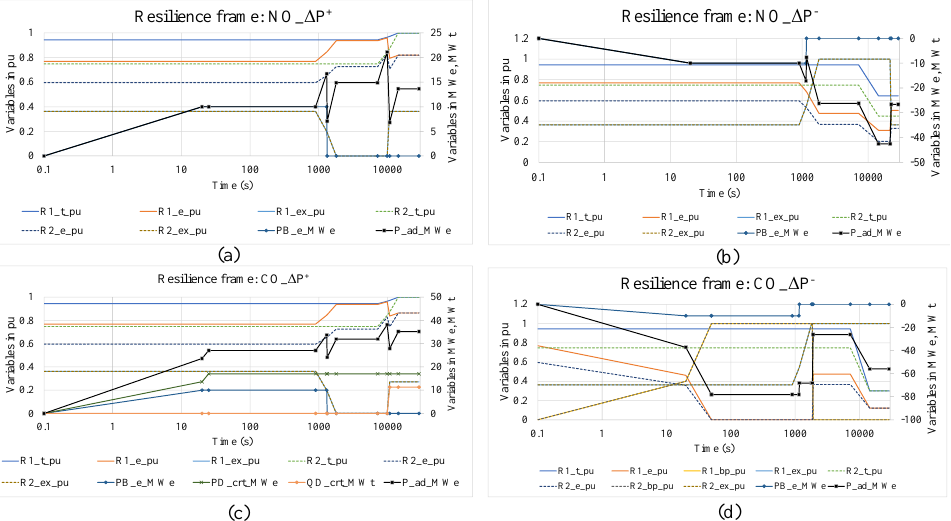
Figure 12. Resilience frames for ∆ P + and ∆ P − in NO and CO at 216.75 h: ( a ) NO_ ∆ P + ; ( b ) NO_ ∆ P − ; ( c ) CO_ ∆ P + ; ( d ) CO_ ∆ P −